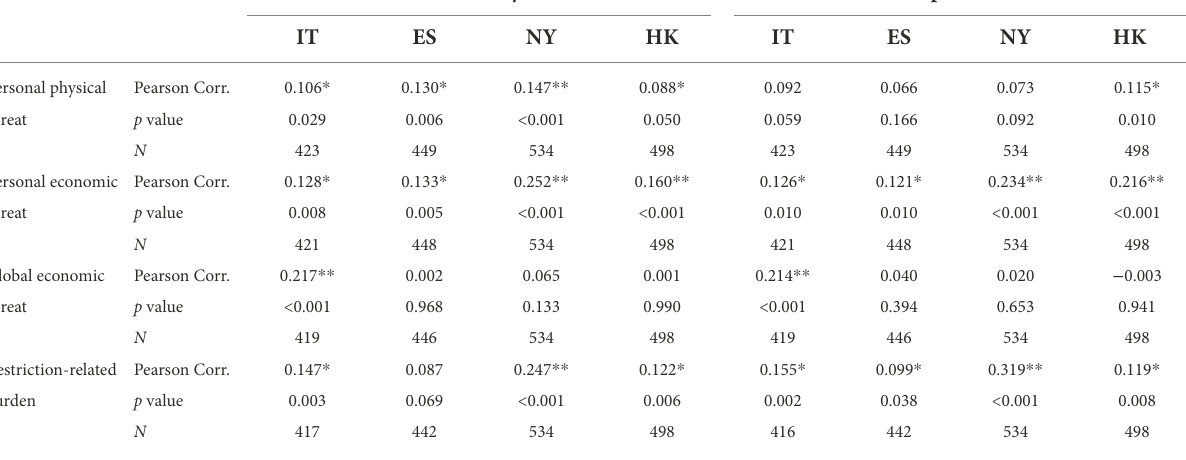
TABLE 5 Correlation matrix between anxiety (GAD-7), depression (PHQ-9), and the factors personal physical threat, personal economic threat, global economic threat, and restriction-related burden by location ***